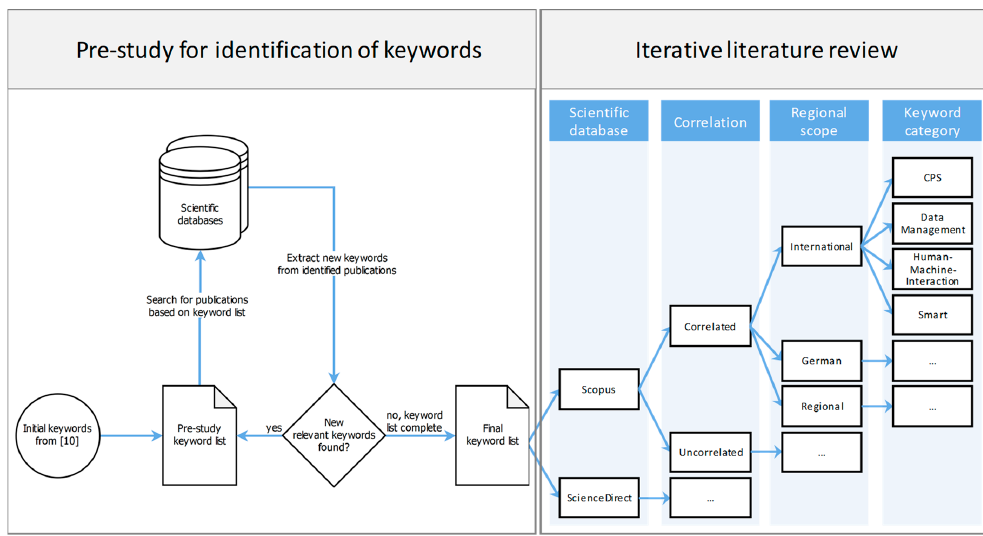
Figure 1. Methodology for the quantitative literature review approach, separated into pre-study for identifying the final keywords and the iterative literature review process.